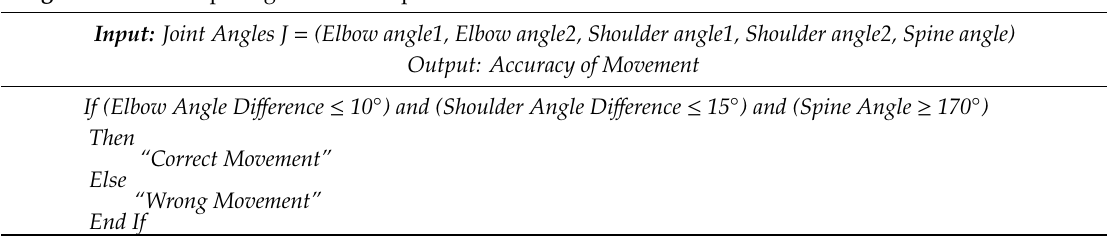
Algorithm 1: Example algorithm of a sports area